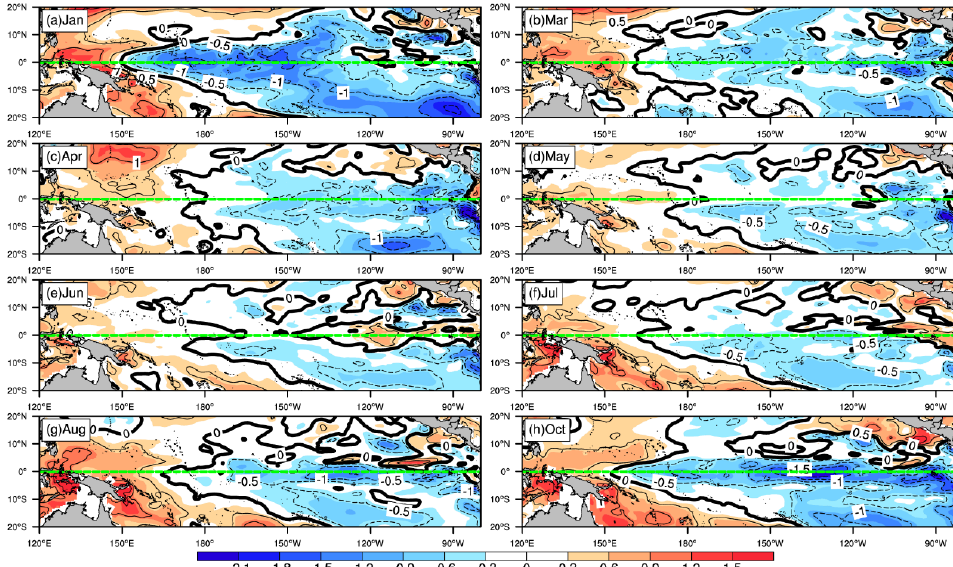
Figure 4. The spatial distribution of SST anomalies in January, March, April, May, June, July, August, and October 2021. The green line marks the equator. The contour interval is 0.5 °C. Compared with the temperature at the surface layer, the subsurface layer variability is the best indicator for studying ENSO. Figure 5 shows the spatial distribution of inter- annual temperature and ocean current anomalies at the thermocline depth. Different from the SST anomalies, in January, the warm and cold subsurface waters were located in the tropical western and eastern Pacific, respectively, separated at 170° W (Figure 5a). From February to April, the warm water at the thermocline depth in the tropical western Pacific began to spread eastward along the equator before eventually occupying nearly the entire equatorial Pacific (Figure 5b,c). In May, the eastward propagation of warm water along the equator in the tropical western Pacific weakened, and the subsurface cold water per- sisted in the off-equatorial region of the eastern Pacific. In June, there was an unexpected occurrence of cold water in the equatorial region between 115° – 125° W, which then inter- rupted the eastward propagation of warm water along the thermocline (Figure 5e). Sub- sequently, the negative temperature anomalies at the thermocline depth gradually inten- sified in the tropical central-eastern Pacific through autumn 2021 (Figure 5f – h). In terms of the ocean current field at the subsurface layers, the ocean current originating from the tropical southeast Pacific showed a prominent northwestward propagation feature in June, transporting cold water to the equator and mixing with the subsurface layer of cold water in the tropical north Pacific. Thus, compared with the SST anomalies, the tempera- ture anomalies at the subsurface layers could provide a clearer reflection of the evolution of the second-year cooling La Niña event, in which the ocean current played a crucial role.